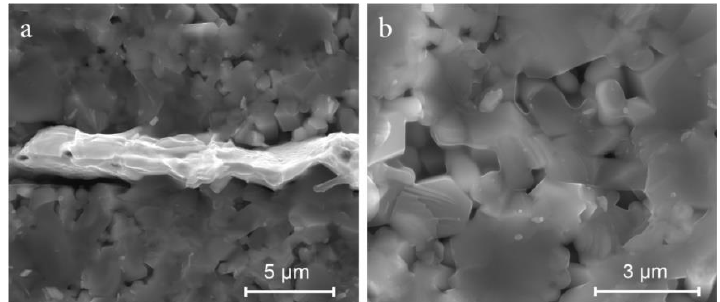
Figure 6. SEM of a low-temperature cofired ceramics (LTCC) structure based on 50% Zn 4 B 6 O 13 –50% Zn 2 SiO 4 ceramic sintered at 950 °C ( a ) ceramic layers with internal screen-printed AgPd thick film, ( b ) ceramic layer.